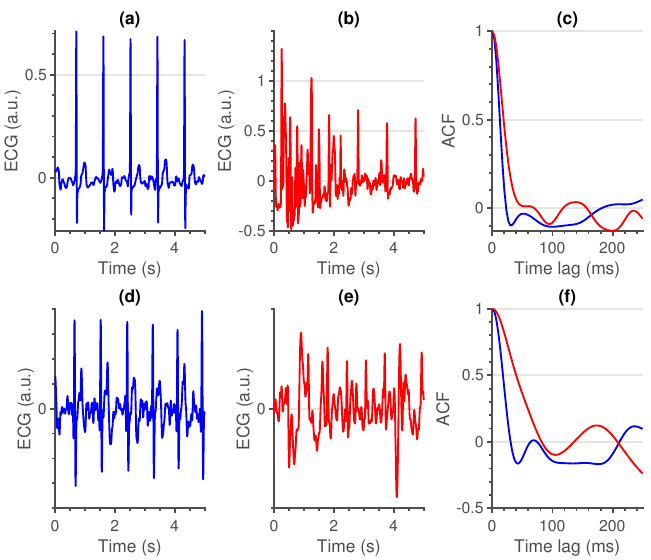
Figure 1. Comparison between a clean (blue) and noisy (red) segment for both contact ( a , b ) and non-contact ( d , e ) signals. A clear difference in autocorrelation function (ACF) ( c , f ) shape can be observed between the two signals.